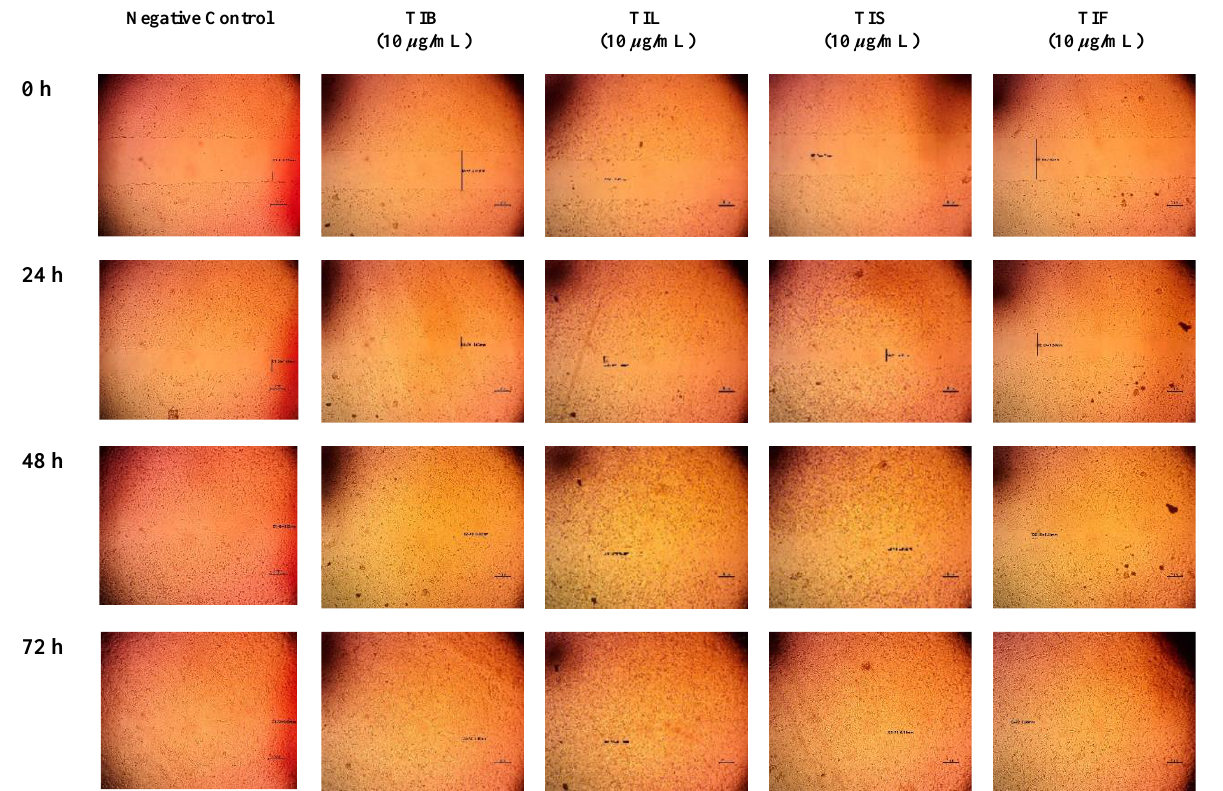
Figure 6. Microscopic images of (HSF) incubated in absence of the plant extract (negative control) and depicting the influence of 10 µg/mL of n -hexane extract from various organs of T. indica : TIB (bark), TIL (leaves), TIS (seeds), and TIF (fruits). Images were captured at 0, 24, 48 and 72 h. The boundaries of the scratched wounds are marked by dark lines.